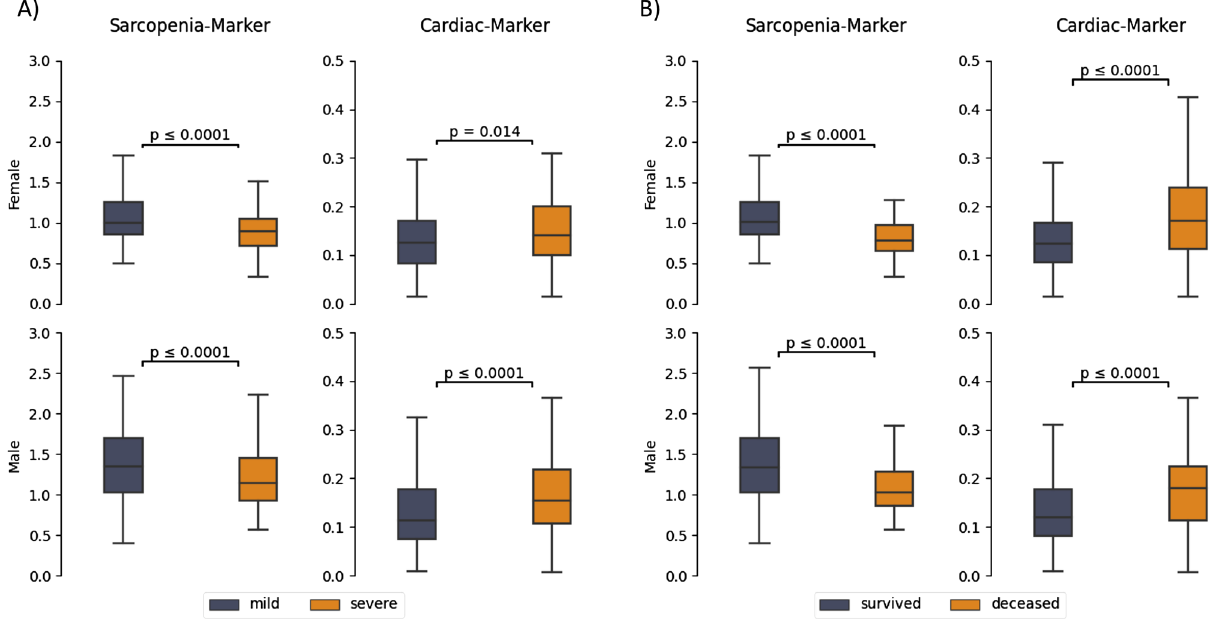
Figure 3. A box plot visualization including Mann–Whitney-U tests of the sarcopenia and cardiac marker for the female patients (first row) and male patients in the cohort (second row). ( A ) Univariate analysis regarding severity ( B ) Univariate analysis regarding mortality.